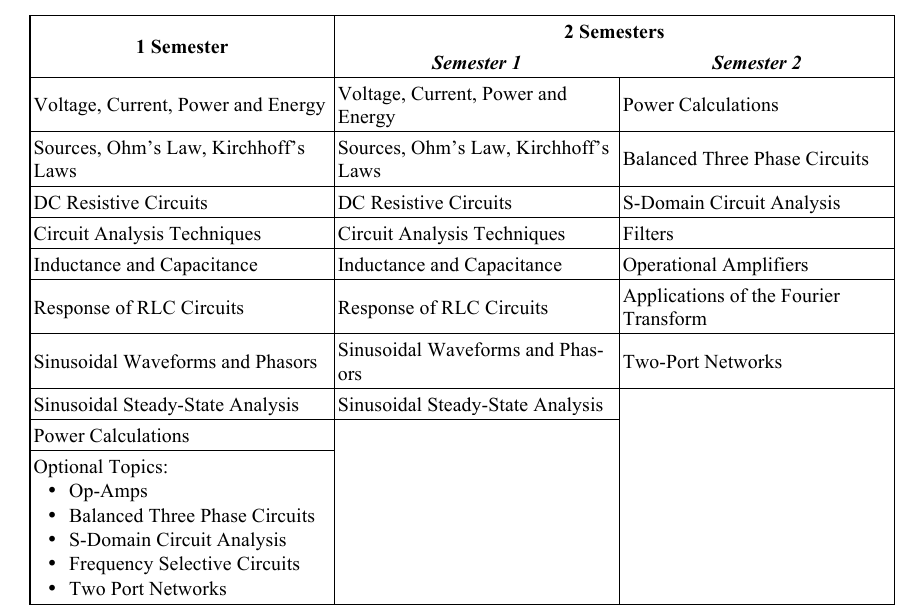
Table 1. Representative topic organization for one and two semester electric circuit analysis